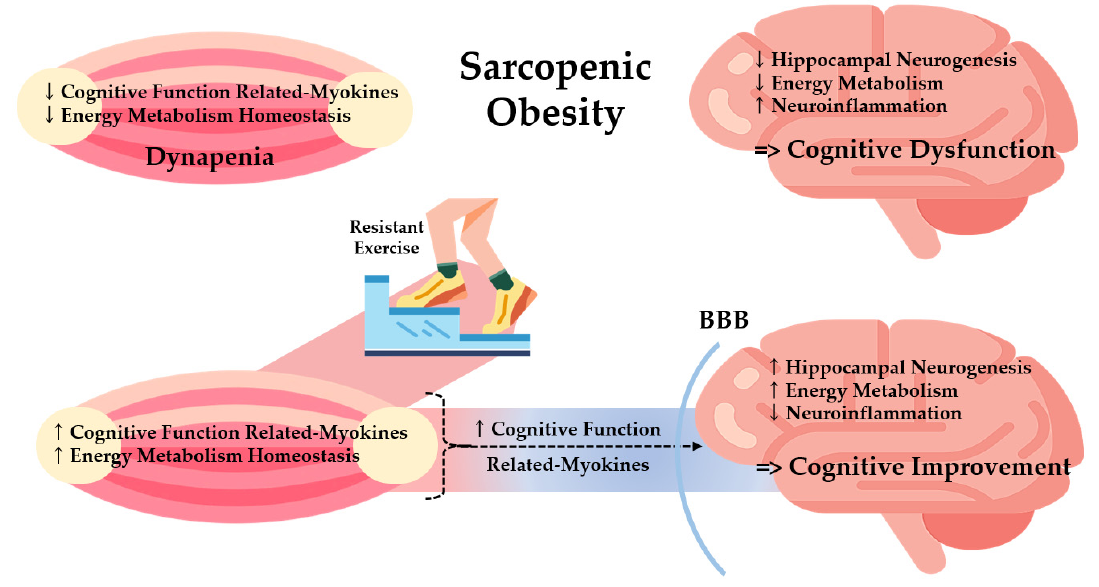
Figure 8. Potential effects of resistant exercise on cognitive and muscle function mediated by myokines in sarcopenic obesity. BBB: Brain Blood